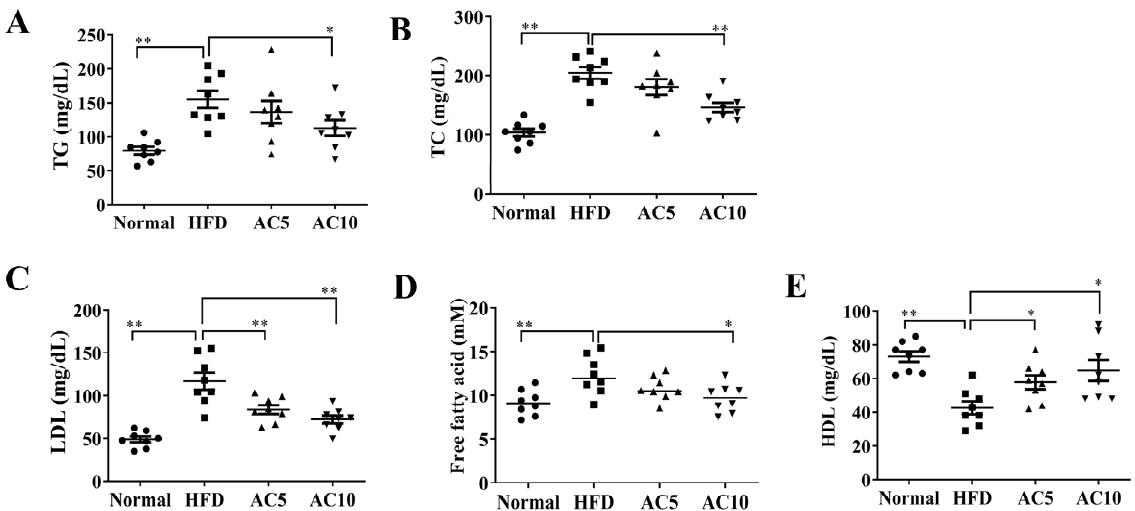
Figure 6. Effects of acacetin (AC) on serum TG and TC in mice. Levels of ( A ) TG, ( B ) TC, ( C ) LDL, ( D ) free fatty acids, and ( E ) HDL. Values are presented as mean ± SEM. * p < 0.05, ** p < 0.01 indicate significant differences compared to obese mice.